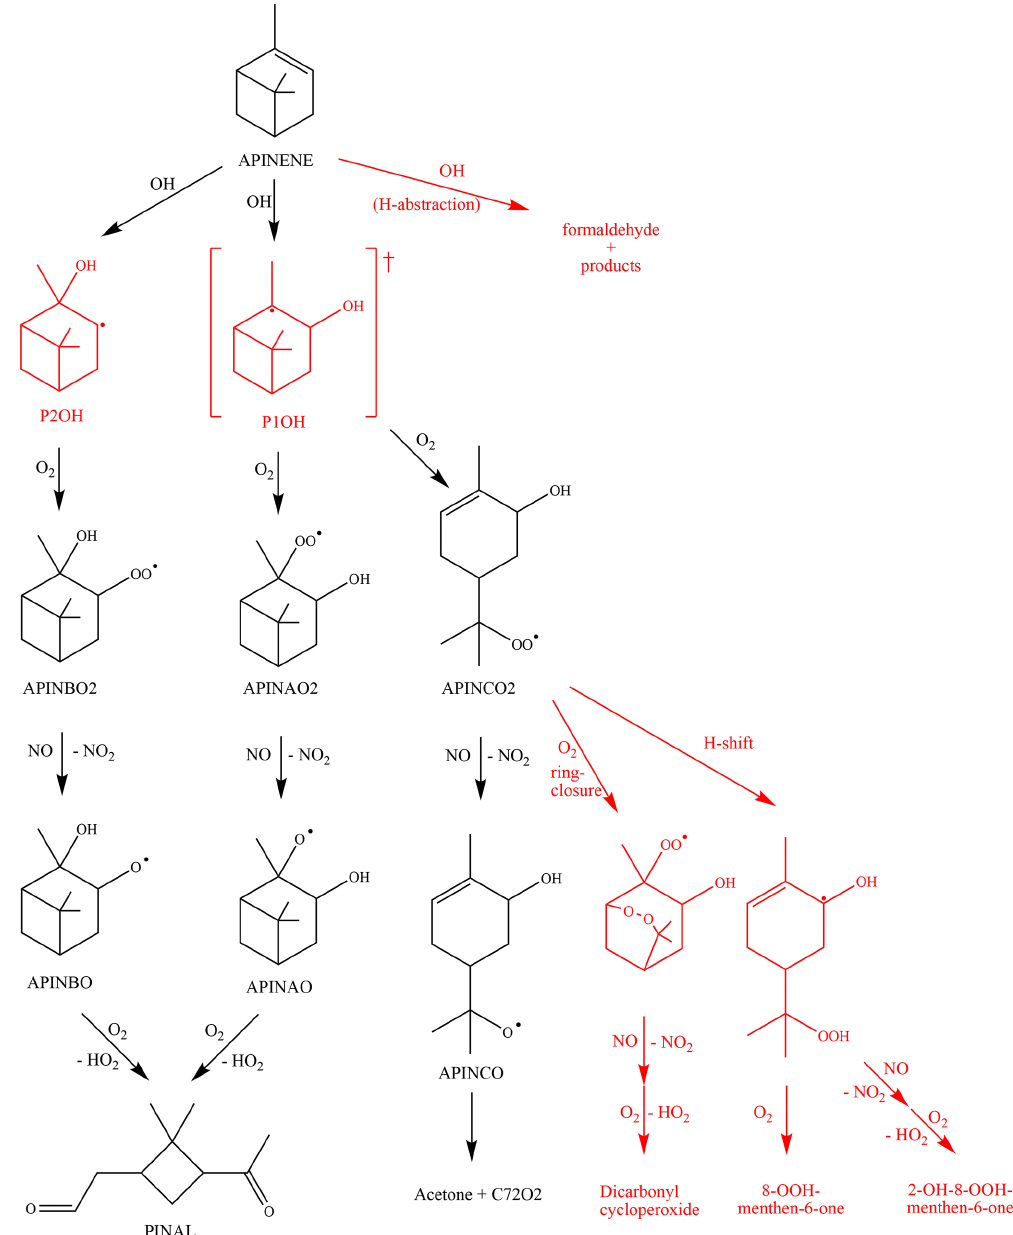
Figure 1. Simplified reaction of α -pinene as described in the MCM and modifications suggested by Vereecken et al. (2007) (shown in red). The hydrogen abstraction consists of three different pathways with a total contribution of 12%. The ring-closure and H-shift reactions in the Vereecken mechanism outrun the formation of APINCO and therefore no acetone is directly formed in contrast to the MCM. RO 2 reactions with NO forming nitrate species are not shown. See text for details. The names are taken from the MCM (black) and according to Vereecken et al. (2007)